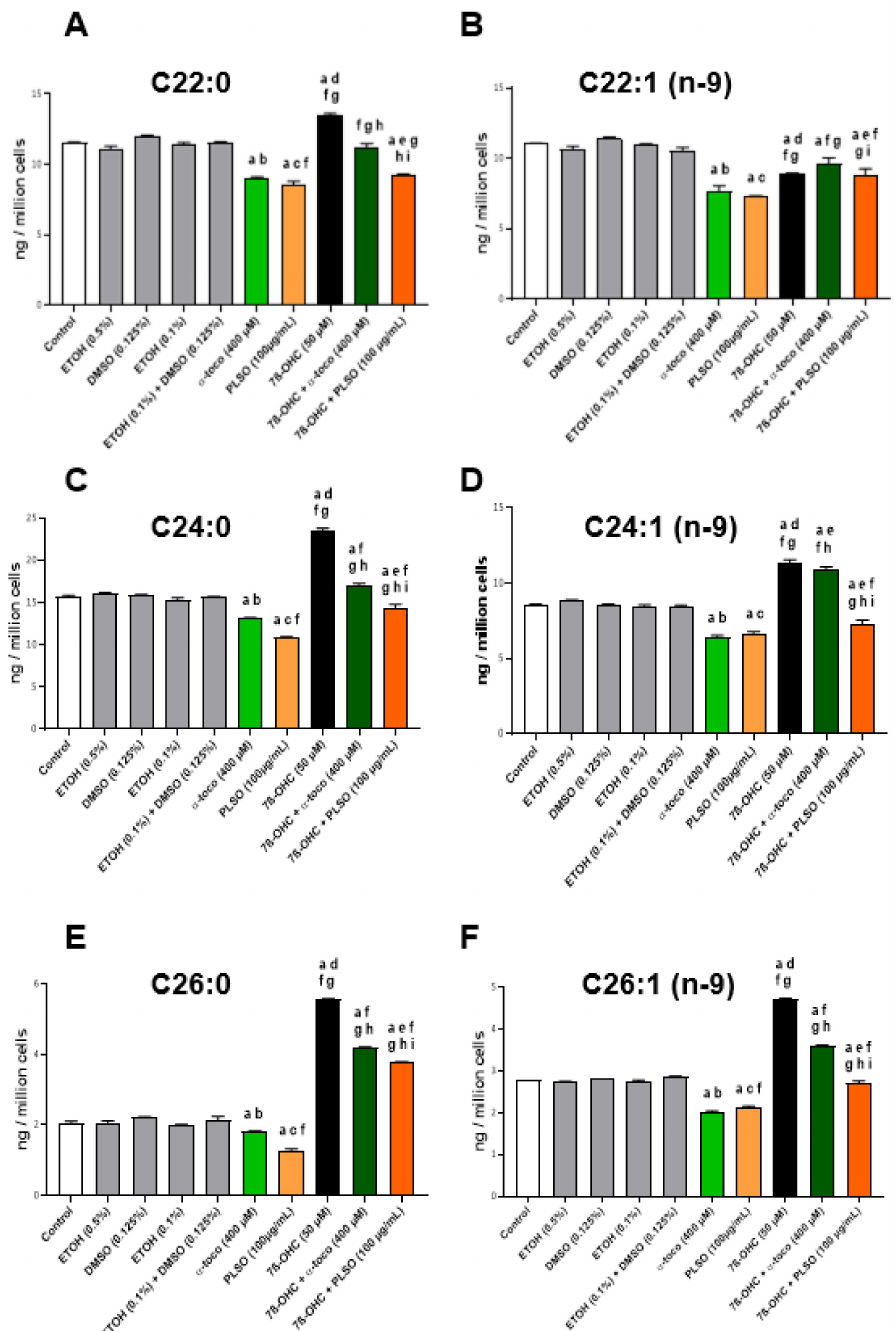
Figure 6. Effect of 7 β -hydroxycholesterol with and without Pistacia lentiscus L. seed oil (PLSO) on very-long-chain fatty acid (VLCFA) levels . C2C12 cells were incubated for 24 h with or without 7 β -OHC (50 µ M) in the presence or absence of PLSO (100 µ g/mL) or α -tocopherol (400 µ M). The level of VLCFA (C ≥ 22) was determined by GC-MS: C22:0 ( A ), C22:1 n − 9 ( B ), C24:0 ( C ), C24:1 n − 9 ( D ), C26:0 ( E ) and C26:1 n − 9 ( F ). Data are the mean ± SD of two independent experiments. A multiple comparative analysis between the groups, taking into account the interactions, was carried out using an ANOVA test followed by a Tukey’s test. A p-value less than 0.05 was considered statistically significant. The statistically significant differences between the groups, which are indicated by different letters, take into account the vehicle used. a: comparison versus control; b: comparison versus ETOH (0.5%); c: comparison versus DMSO (0.125%); d: comparison versus ETOH (0.1%); e: comparison versus (ETOH (0.1%) + DMSO (0.125%)); f: comparison versus α -toco (400 µ M); g: comparison versus PLSO (100 µ g/mL) ; h: comparison versus 7 β -OHC (50 µ M); i: comparison versus 7 β -OHC (50 µ M) + α -toco (400 µ M). No significant differences were observed between the untreated (control) and vehicle-treated